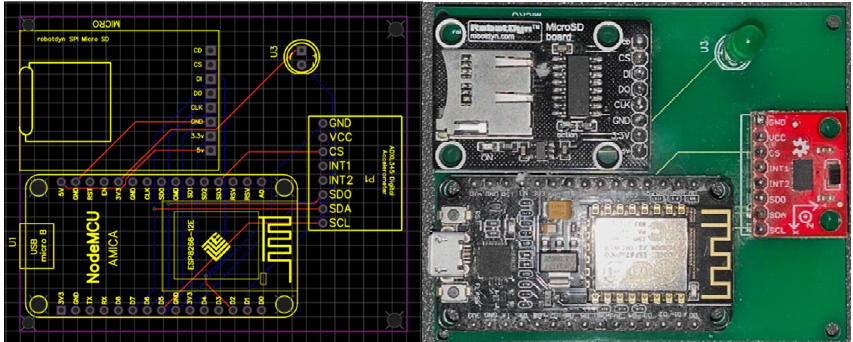
Figure 1. Schematic design and circuit board of the sensor device.